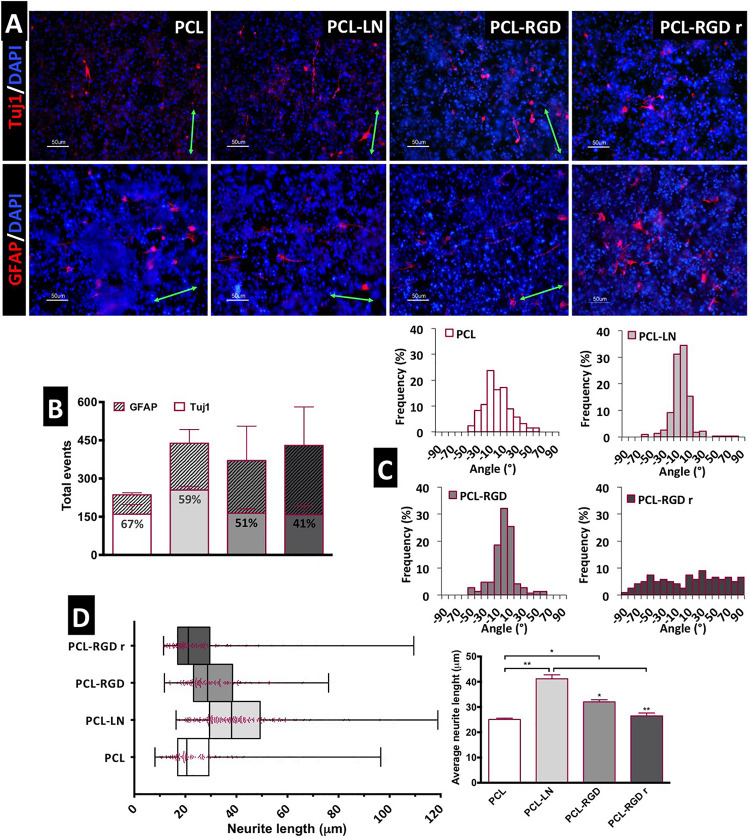
Evaluation of in situ CGR8-NS differentiation: (A) Immunofluorescence images of the expression of the neuronal marker βIII-tubulin (Tuj1) and astrocyte marker GFAP (green arrows indicate the fiber direction). (B) Total differentiated cells (events) counted. (C) Histograms of neuron alignment distribution. (D) Representation of the neurite length distribution (on the left). The box boundaries represent the 25th and the 75th percentile; the straight line inside the box is the median. On the right, average neurite lengths; a minimum of 50 cells were measured; *p < 0.05; **p < 0.01 (n = 2).